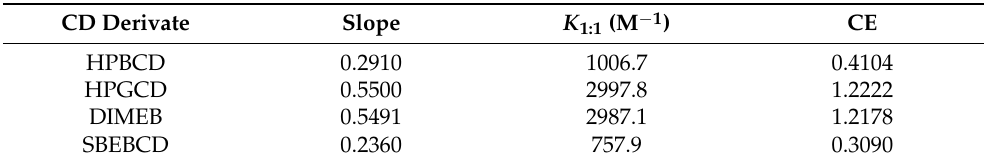
Table 2. K 1:1 and CE values of the DXM-CD derivate inclusion complexes and the slope of the linear